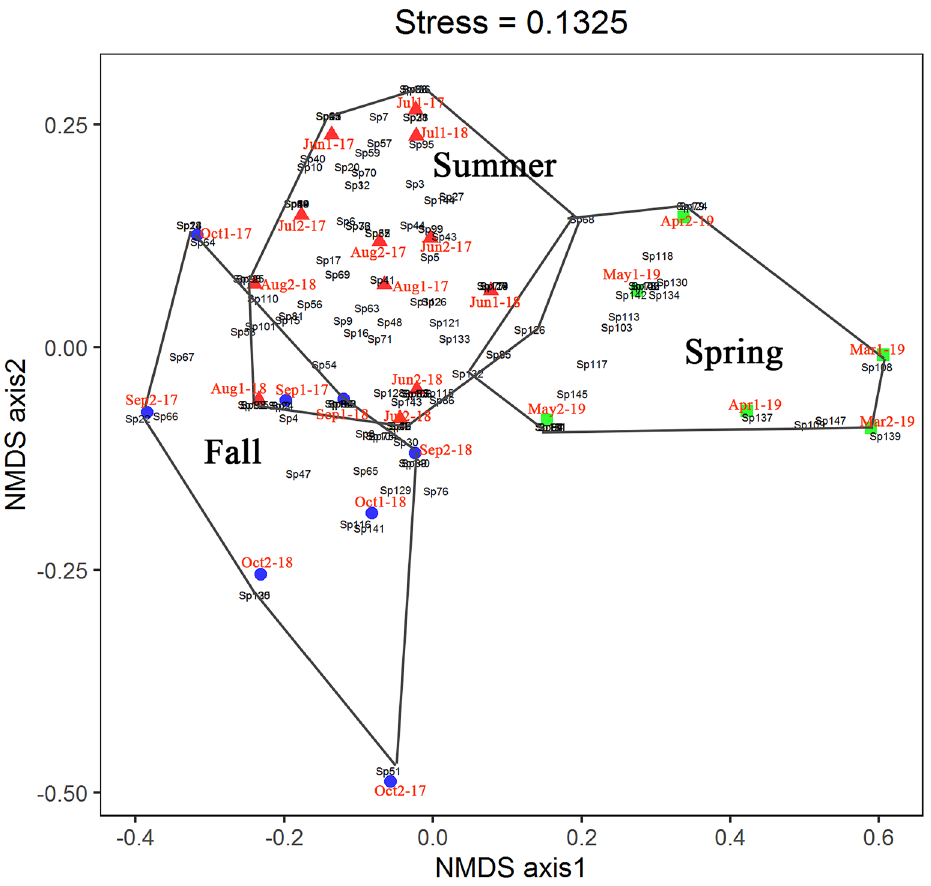
Figure 6. The 2-dimensional NMDS ordination configuration plot showing sample dates and points (black) for species using the Bray–Curtis dissimilarity matrix. Polygons group spring, summer and fall